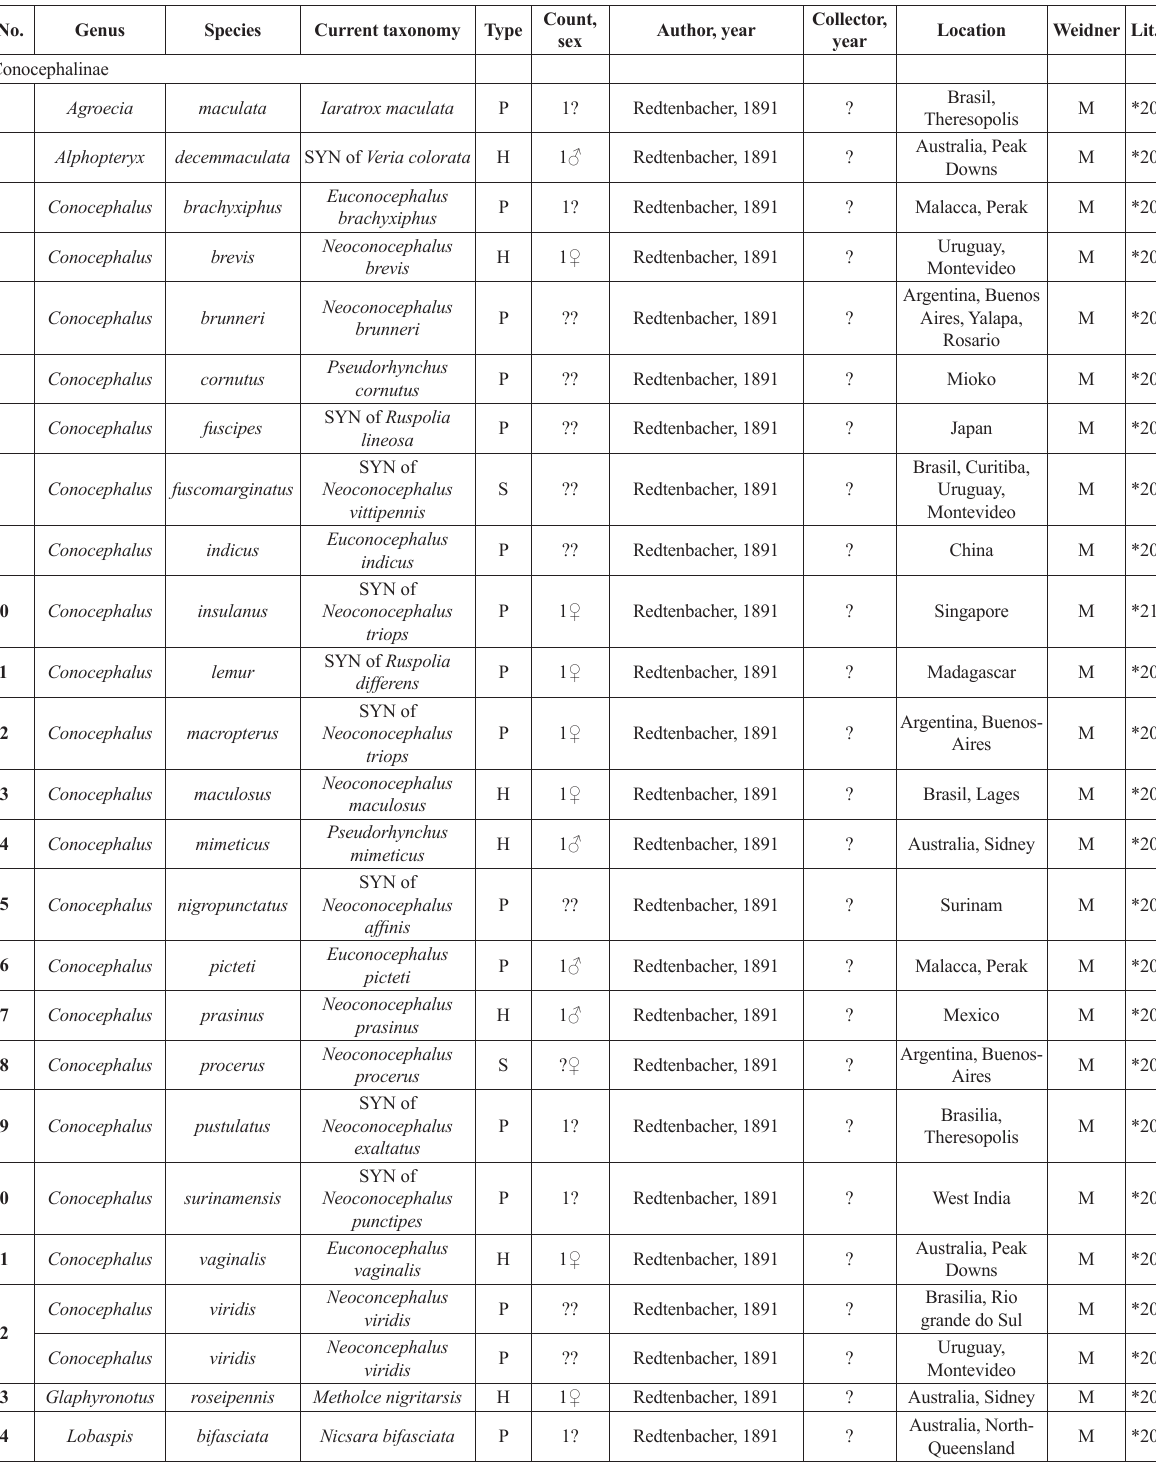
Table 2. The table shows all type specimens that should be in the collection based on the literature and card system, but are currently missing in the collection of the ZMH; given are the original genus and species name, the type status including the abbreviations H for holotype, P for paratype, and S for syntype. The number and sex of missing type specimens are presented. Moreover, the table shows information about author and year of description of the material. Furthermore, the collector, date of collection and collection location are provided. We also present the current nomenclature as in Cigliano et al. (2018). Additionally, the old type catalogues of Weidner (1966, 1977) were compared with the present list of missing data: Y = yes, the species was present in Weidner (1966, 1977), M = missing and A = absent (the material was not shown in the old type catalogue, but is in the card system). The Lit. column shows the reference number of the original description. The references of the numbers are included below. Question marks indicate missing